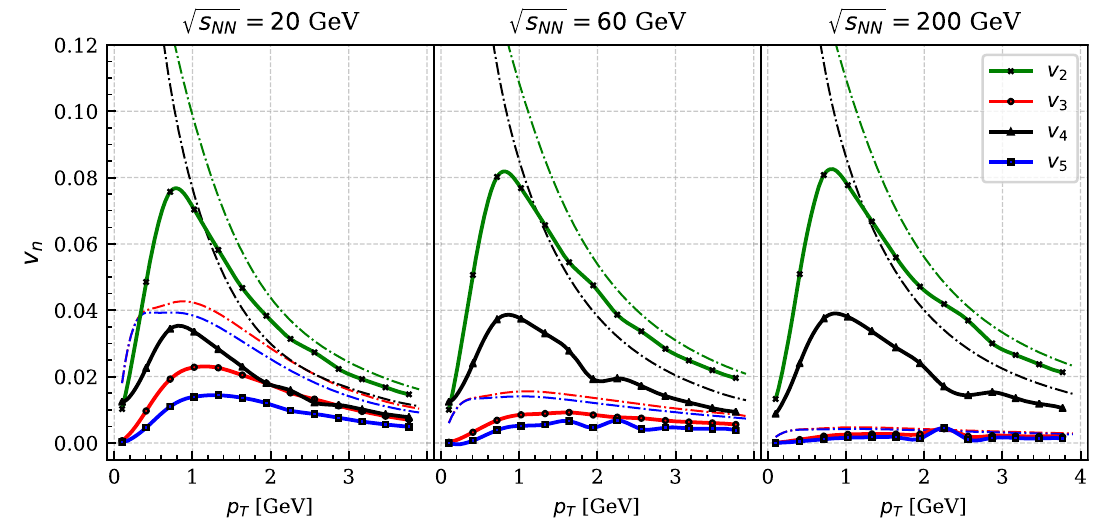
using μ 2 ( k 1 , k 2 ) ∝ ( 2 π) 2 δ ( 2 ) ( k 1 − k 2 ) andthecontinuouslinesemploy